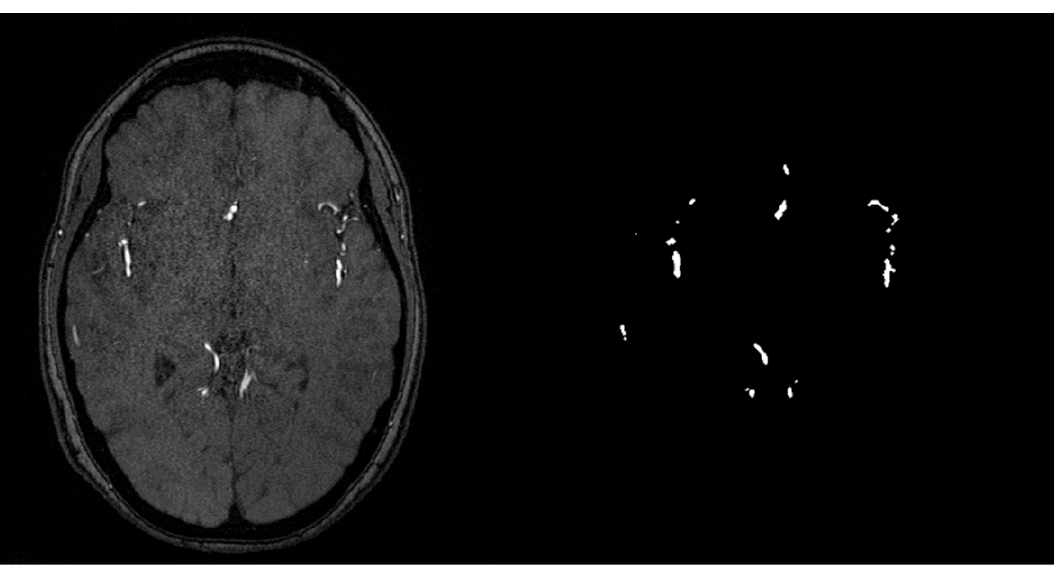
Figure 1. Axial view from a sample of the MRA dataset and its segmentation map.